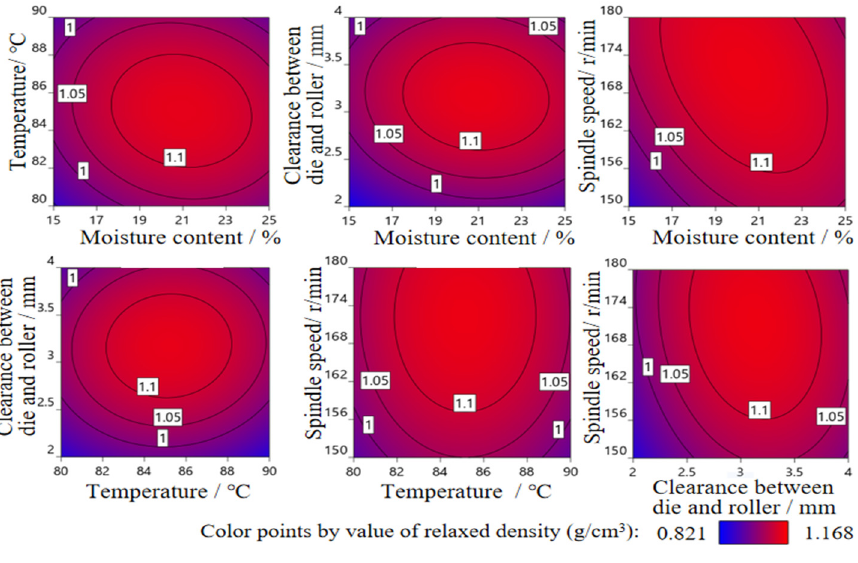
Figure 7. Contour sheet of relaxed density.